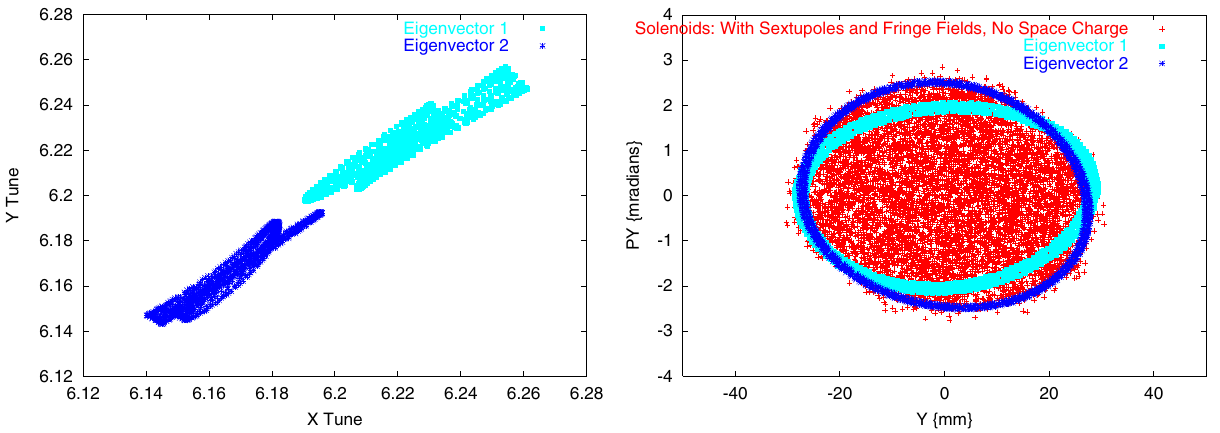
FIG. 2. (Left) Tune footprint for the two eigenvectors, each taken turn by turn over 1000 turns. (Right) Eigenvector projections in vertical phase space, together with self-consistent beam distribution painted to one (dark blue) of the eigenvectors.